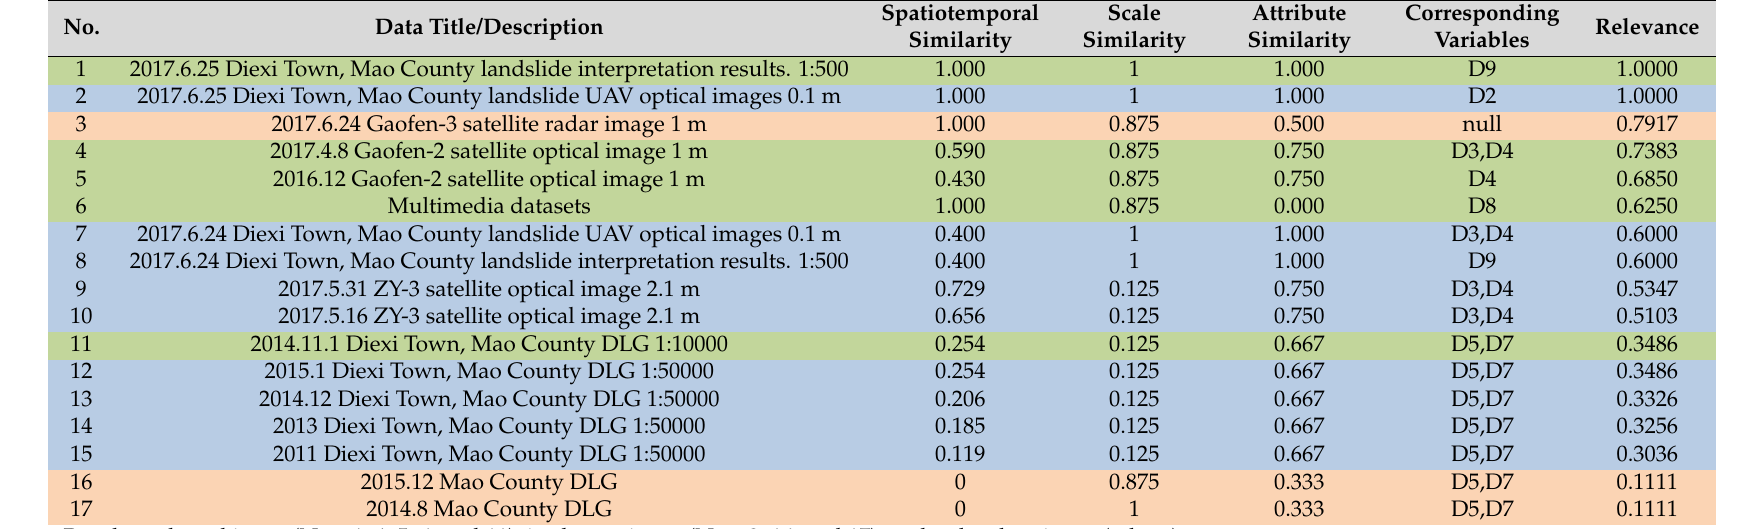
Table 1. Data selection results of the proposed